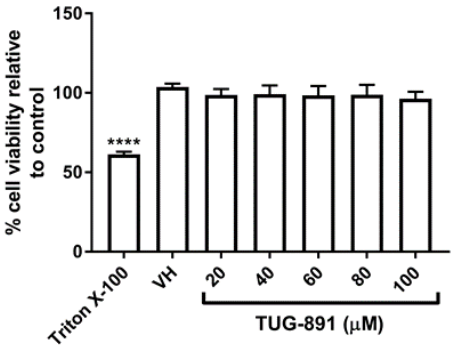
Figure 1. Effect of TUG-891 on cell viability in RAW264.7 macrophages. RAW264.7 macrophages were seeded into 96-well plates and exposed to TUG-891 (20–100 µM) for 48 h. Triton X-100 (0.1%) was used as a positive control for cytotoxicity. Cell viability was determined by a resazurin assay. VH: vehicle control. **** p < 0.0001 vs.